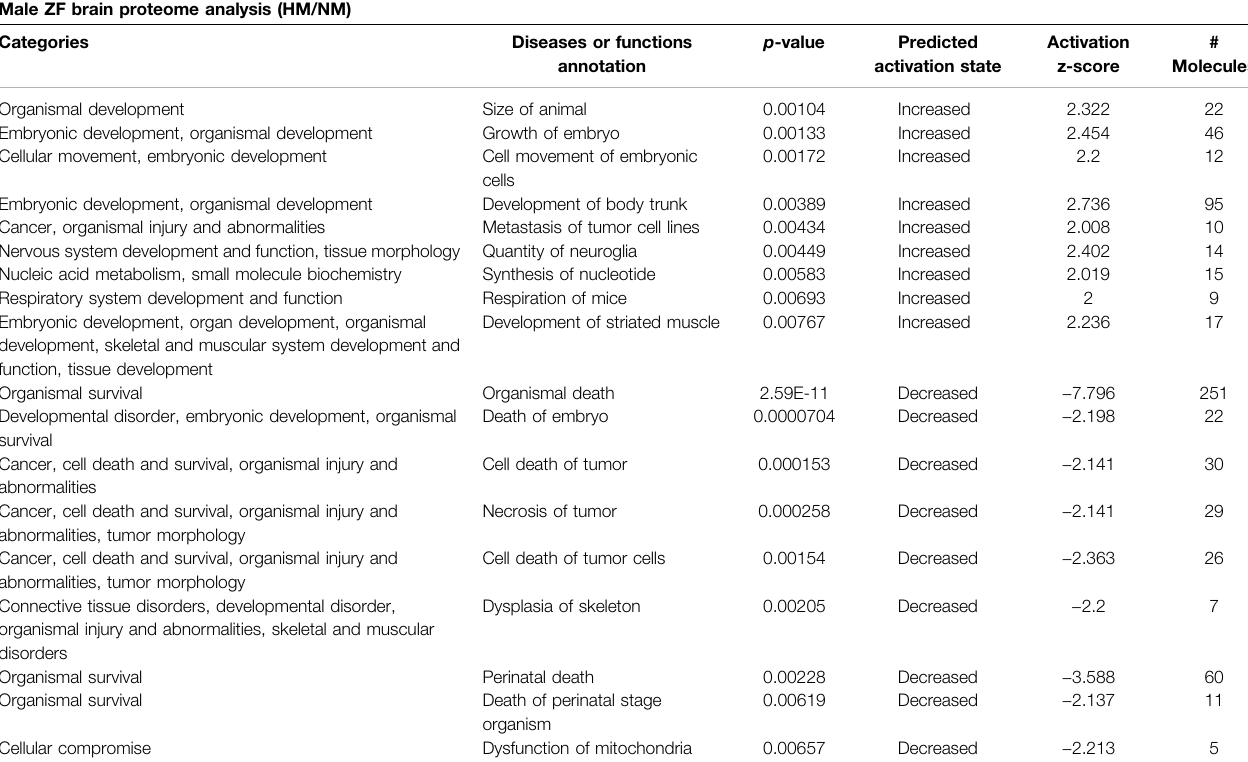
TABLE 1 | ( Continued ) IPA generated disease function analysis for zebra fi sh male and female brain proteome induced by hypoxia following